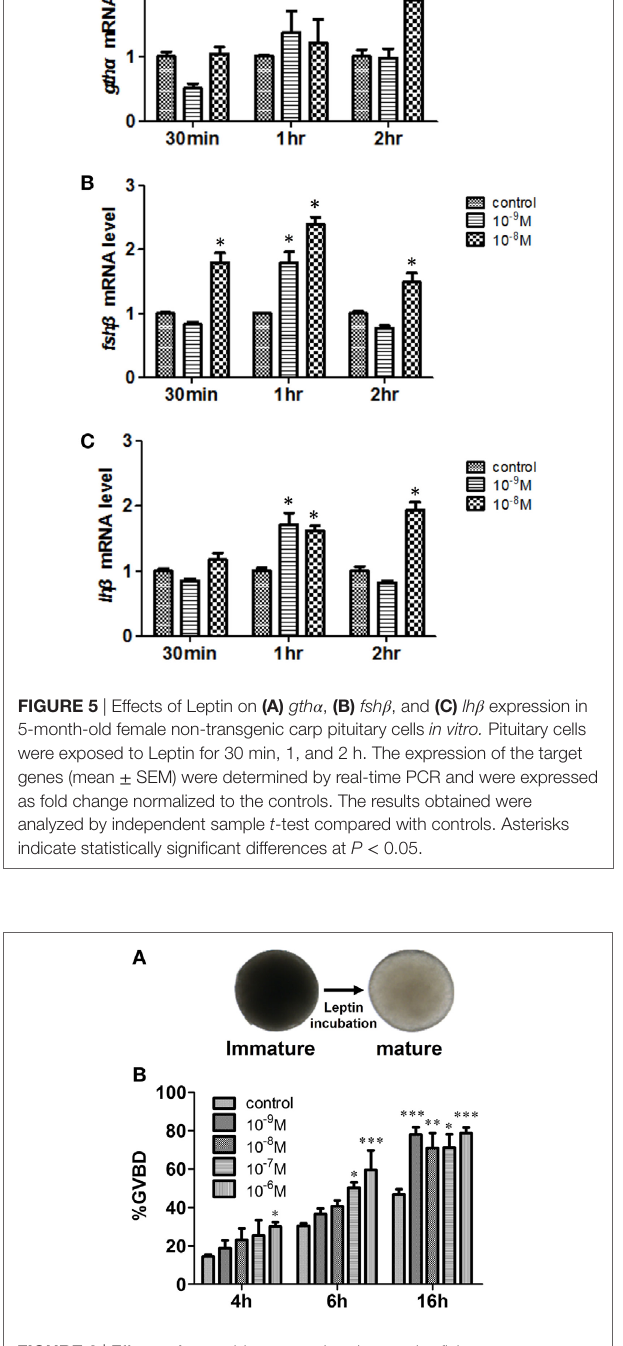
FigUre 6 | Effects of recombinant carp Leptin on zebrafish oocyte maturation. (a) Fully growth follicles were treated with recombinant carp Leptin. The follicles became mature (transparent) after germinal vesicle breakdown (GVBD). (B) The % follicles undergoing GVBD was scored and assessed. Each value represents the mean ± SEM of three independent experiments.